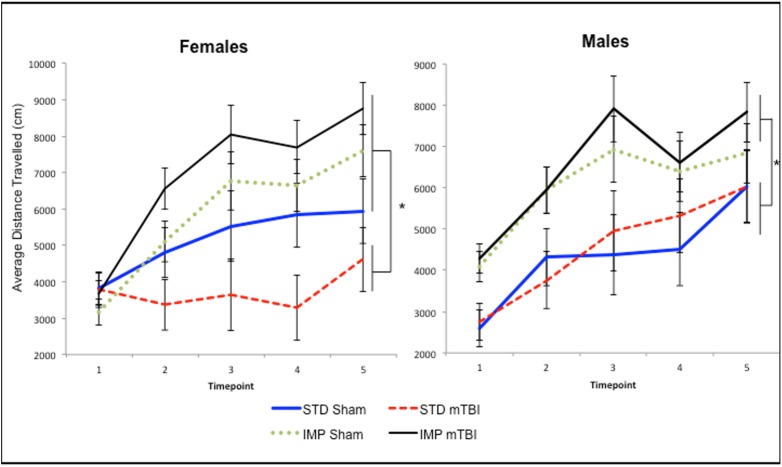
Graphical representation of the average activity level for A) Males, and B) Females, demonstrating that the IMP cohorts were significantly more active than the STD animals at each of the 5 distinct time-periods with STD-mTBI females also showing significant reductions in activity when compared to STD-shams (*main effect of cohort, p < .05).